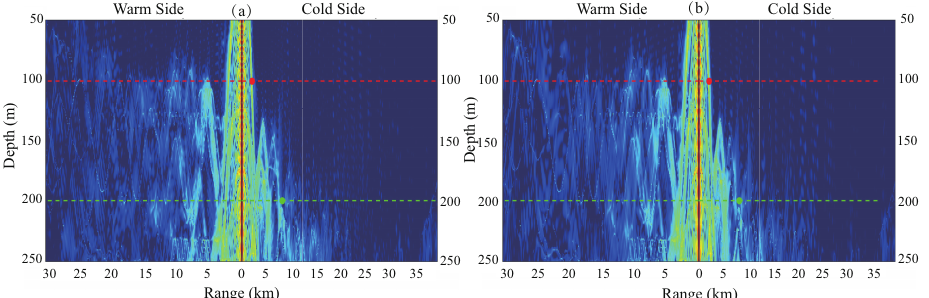
Figure 23. 3D simulation of sound pressure transmission loss at the frequency of ( a ) 120 Hz and ( b ) 200